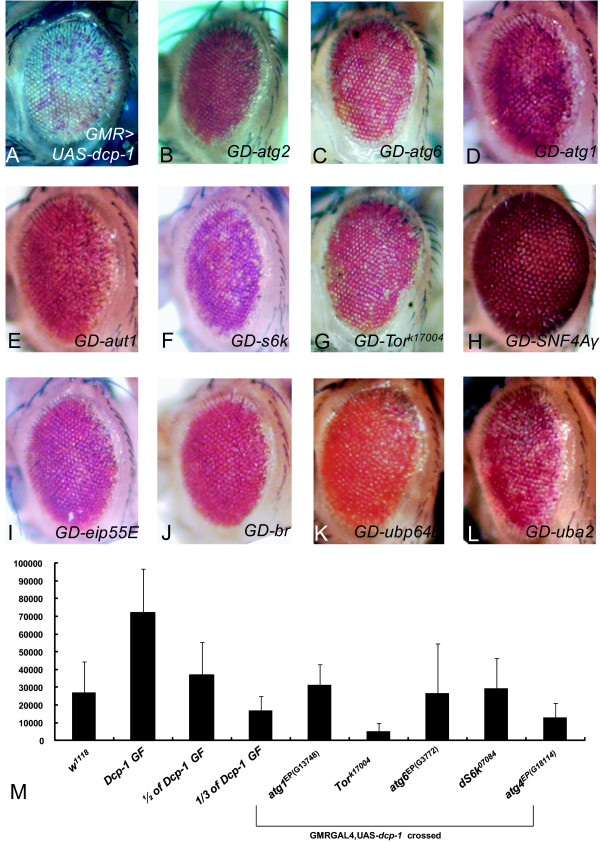
Suppressors of the Dcp-1 GF eye phenotype. (A) Dcp-1 GF, The Dcp-1 eye phenotype of flies with a single copy of Dcp-1 GF was suppressed by: (B) Atg2EP(G6691), (C) Atg6EP(G6854), (D) Atg1EP(G13748), (E) Aut1EP(G3894), (F) UAS-dS6k, (G) Tork17004, (H) SNF4AγEP(GX6409), (I) Eip55EEP(G13564), (J) brEP(G10174), (K) Ubp64EEP(G5032), and (L) Uba2EP(G4384). Each panel shows the effects of each gene in the Dcp-1 GF background. GD- indicates DCP-1 expression with each transgenes by crossing with Dcp-1 GF. (M) Caspase activity was determined with lysate from heads of each virgin flies from w1118, GMR-GAL4;UAS-Dcp-1 and GMR-GAL4;UAS-Dcp-1 which were crossed with autophagy related lines. Samples that provided statistically significant reduced activity in at least three independent experiments are shown (*, P < 0.05; **, P < 0.1 t test). RLU, relative light unit. The error bars represent the standard deviation of amount of RLU (B, C, D and E).